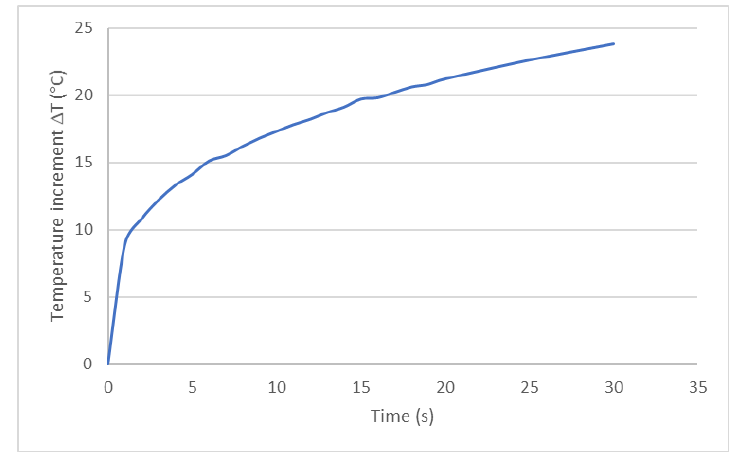
Figure 3. Stoll and Chianta diagram